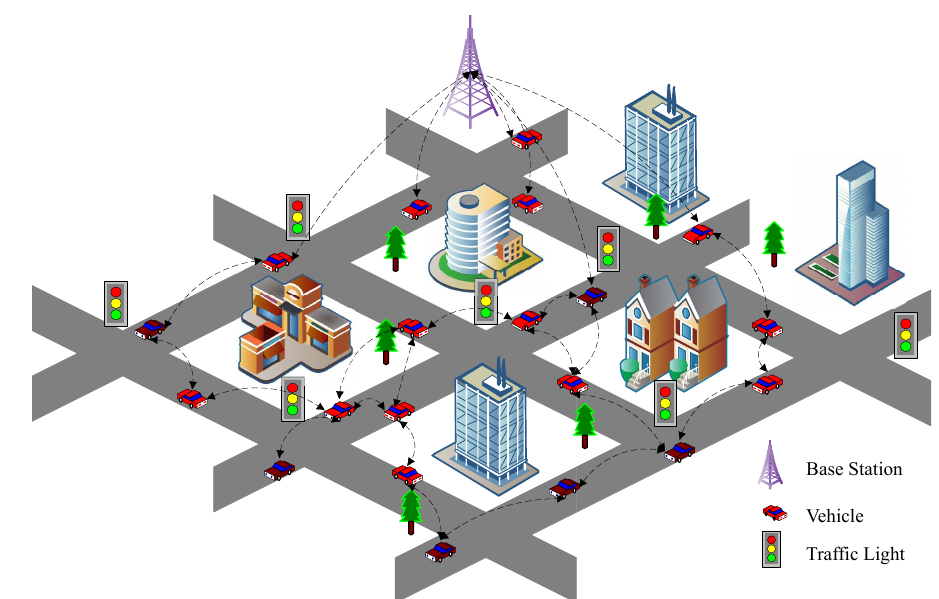
Figure 2. Typical VANETs